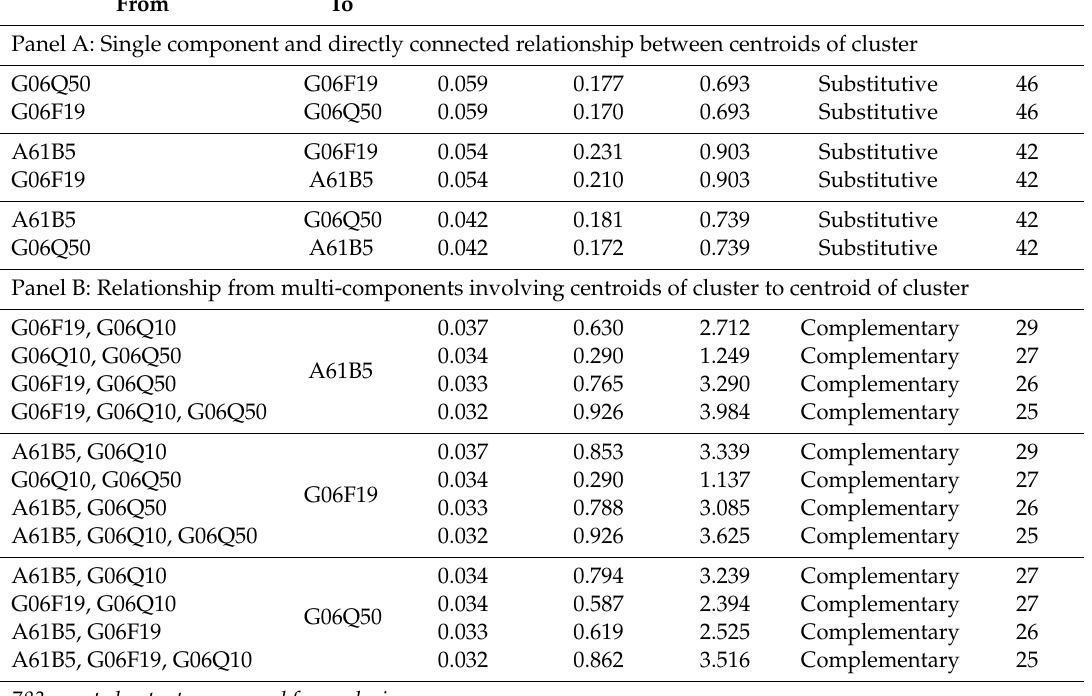
Table 4. Various relationships of centroids of clusters in the science-based pharmaceutical innovation period (2000–2007). Centroid Support Confidence Lift Relationship Count From